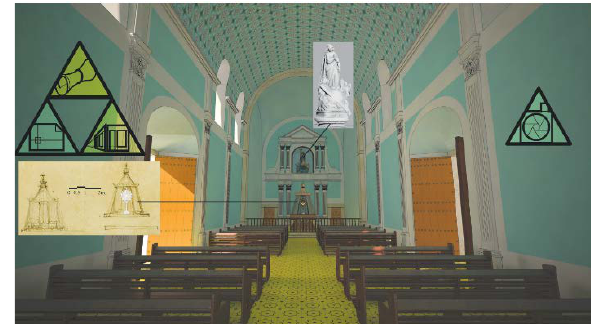
Figure 7. Interior virtual reconstruction of the Jesús María temple. It includes the project of cypress; a canopy or umbraculum (veil in pavilion’s form) can be seen. The graphic scale corresponds to the dimensions of the original drawing.